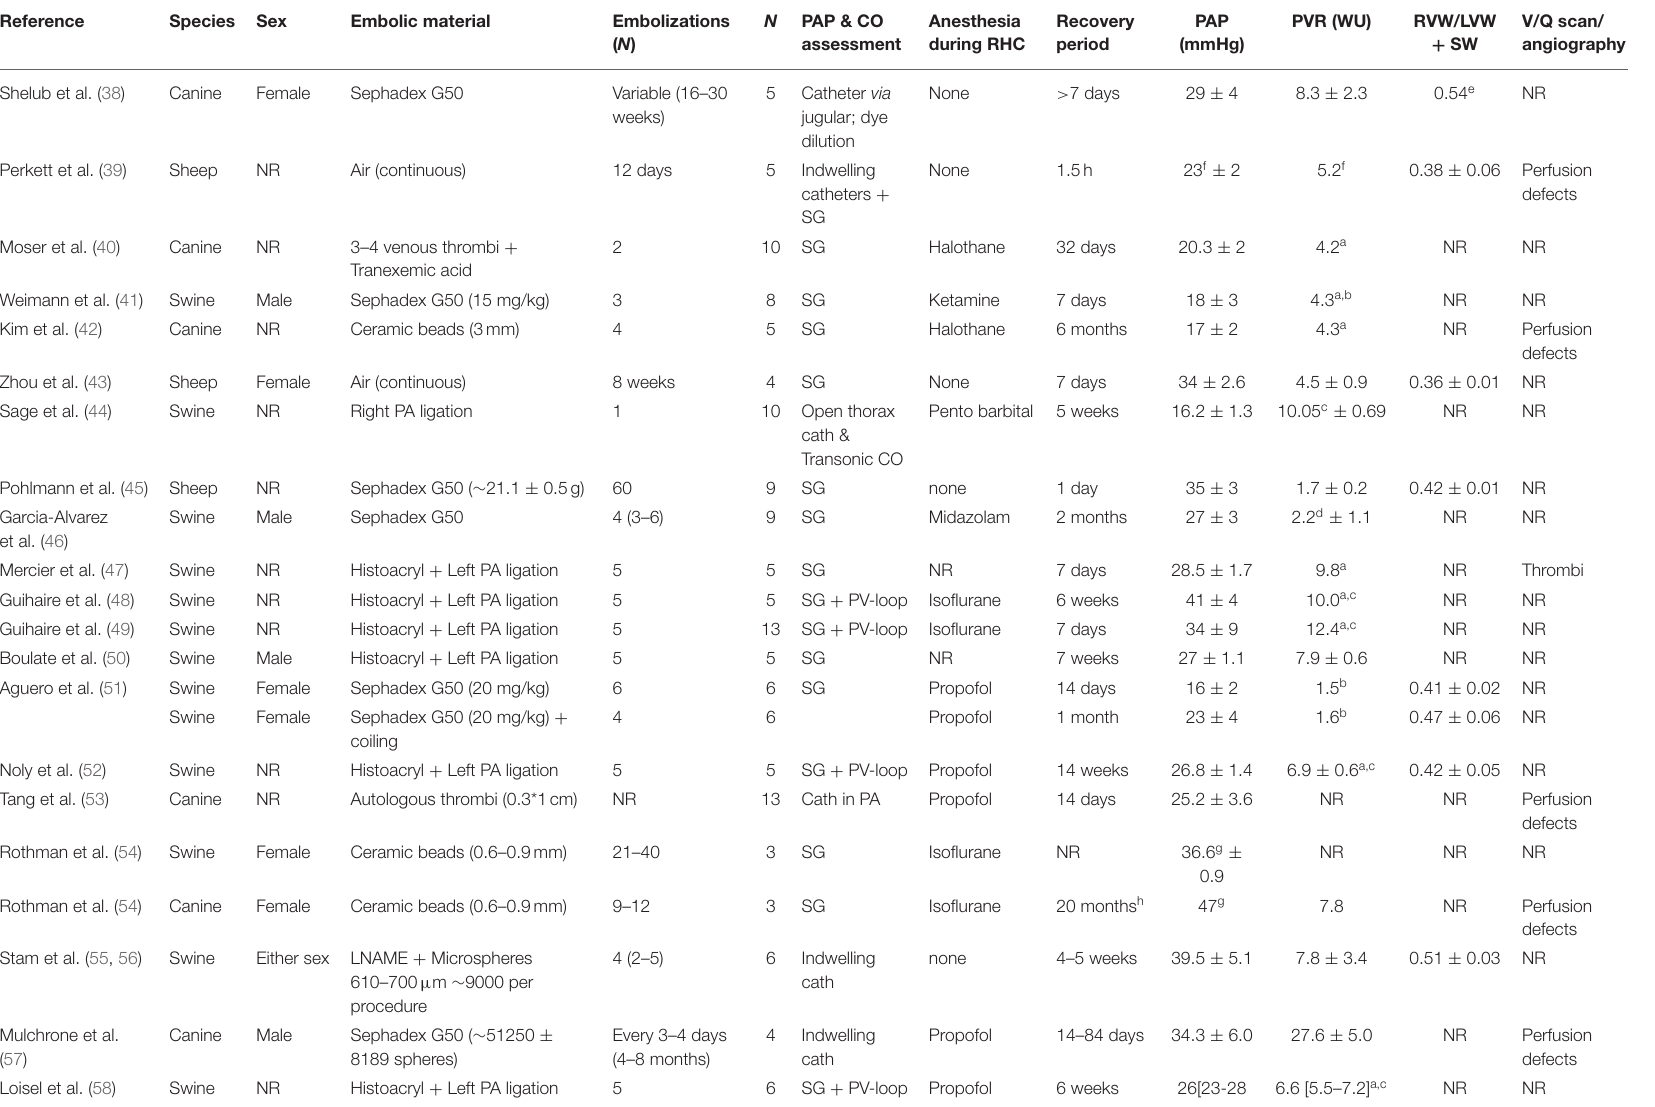
TABLE 1 | Overview of large animal studies utilizing embolization techniques to create CTEPH/CTED, adapted from